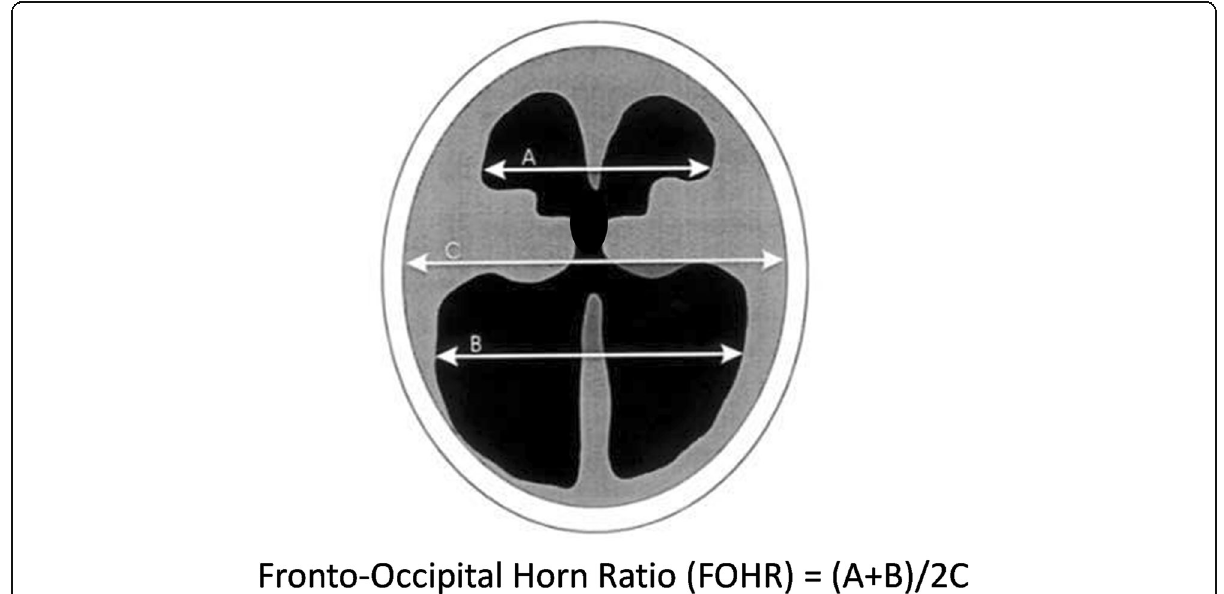
Fig. 1 Anatomical landmark and measurement set for the fronto-occipital horn ratio (FOHR) ratio when measured on CT